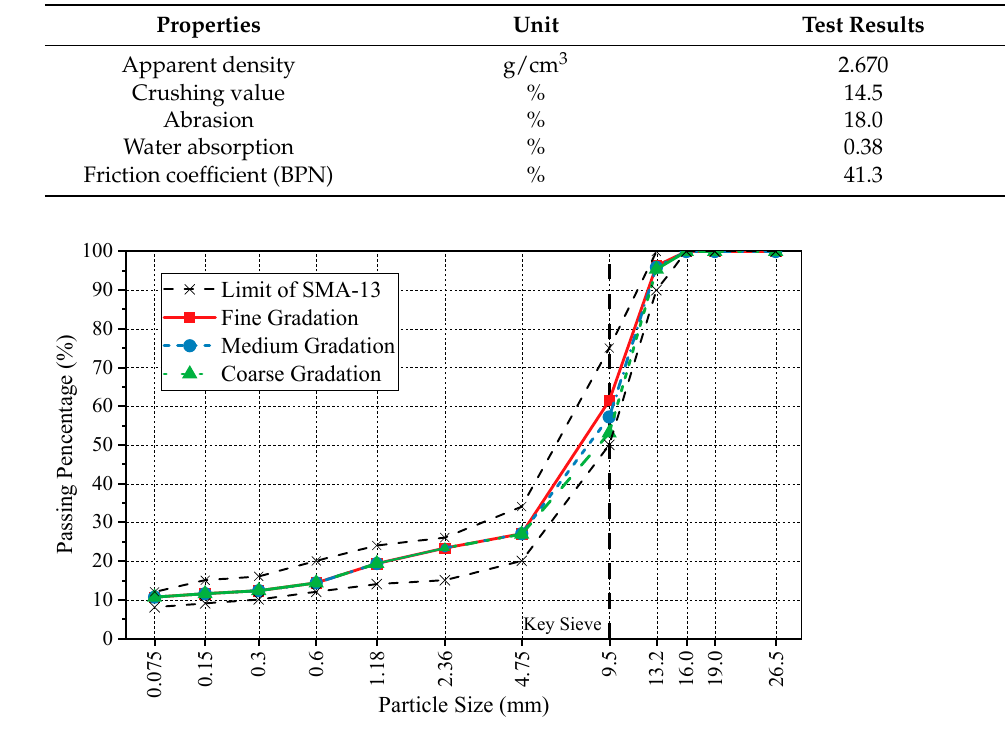
Figure 1. Grading curve for three types of SMA-13. Table 3. Material designs of SMA-13 specimens.